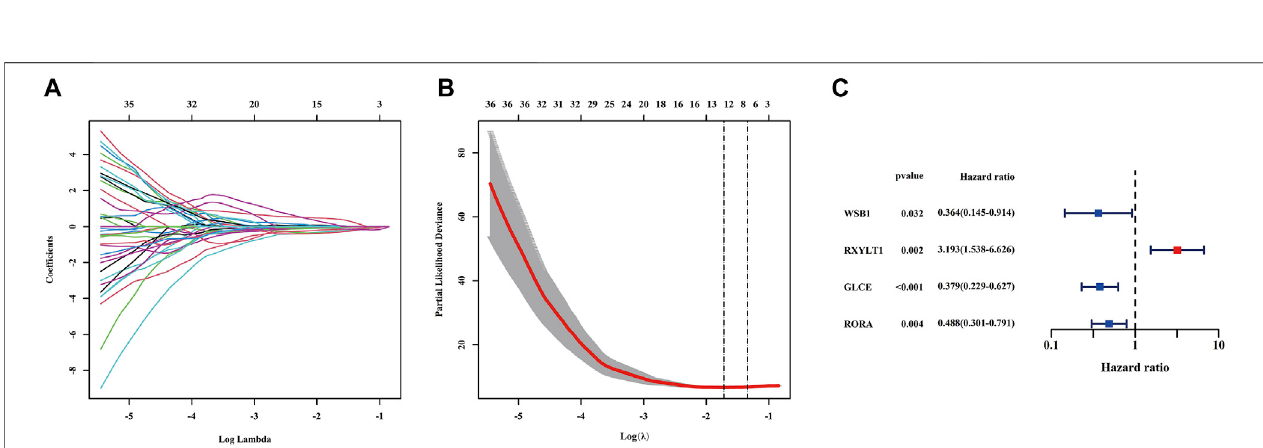
FIGURE 1 | Tumor classi fi cation based on the differently expressed HRGs. (A) Flow chart of data analysis. (B) Volcano plot of DEGs between tumor and normal tissues. (C) Veen plot of DEGs and HRGs set. (D) All EWS patients were divided into two clusters by NMF cluster based on 52 HRGs (k = 2). (E) Heatmap shows the association of risk and clinicopathologic characters in two clusters. (F) KM curves of the two clusters.